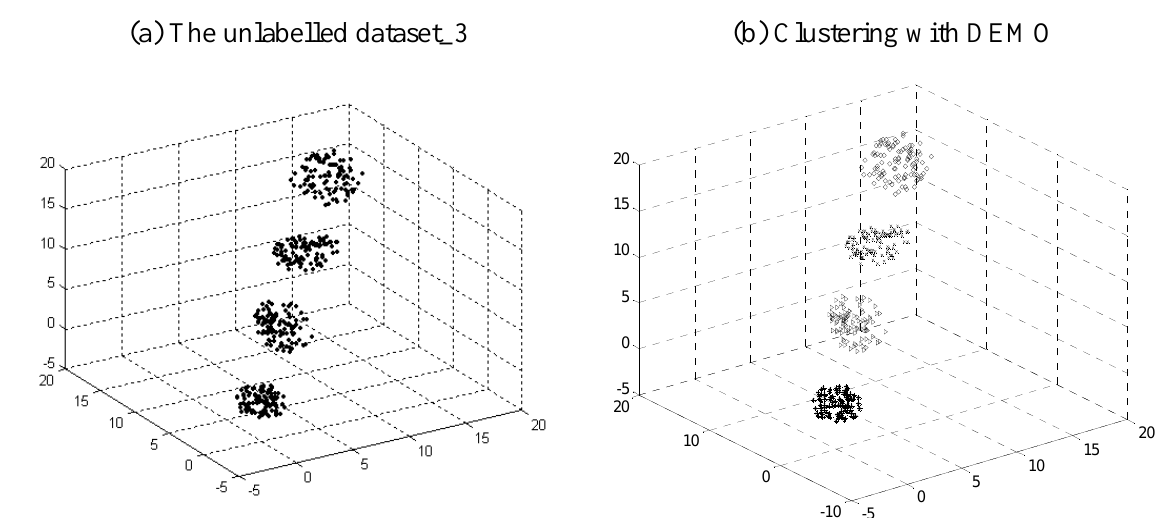
Figure 6. Clustering result for artificial dataset_3.